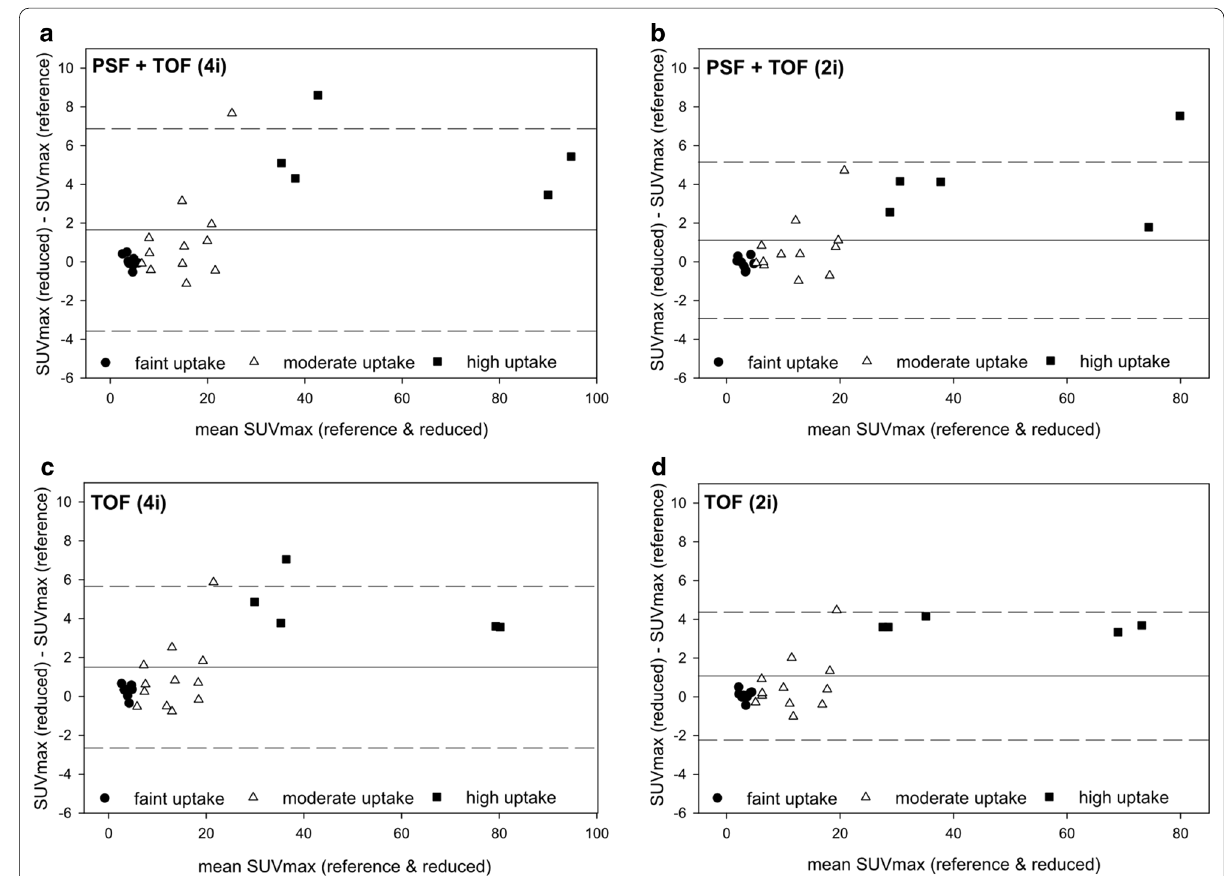
Fig. 4 Bland–Altman plots showing the agreement of SUVmax between images acquired with reduced vs. standard emission time reconstructed with PSF TOF (4i, panel a ) PSF TOF (2i, panel b ), TOF (4i, panel c ), and TOF (2i, panel d ). A systematic overestimation of high-uptake lesions was + +